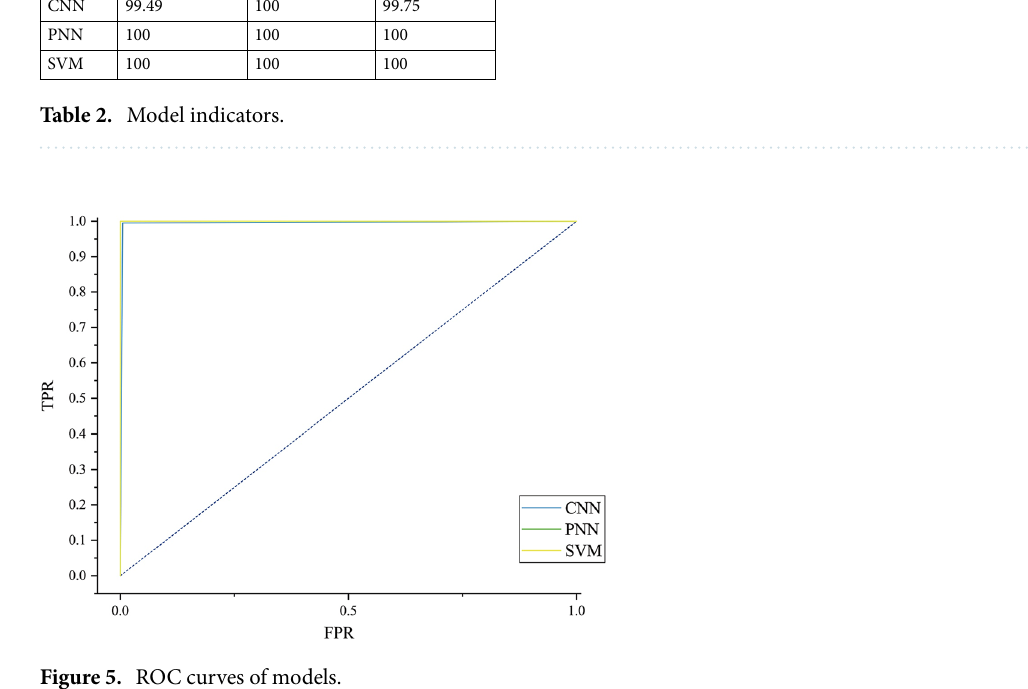
Figure 5. ROC curves of